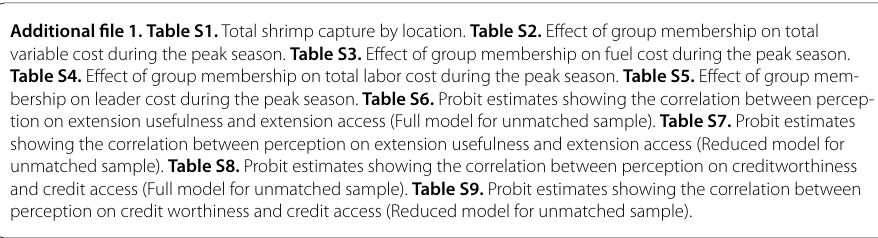
Table S4. Effect of group membership on total labor cost during the peak season. Table S5. Effect of group mem- bership on leader cost during the peak season. Table S6. Probit estimates showing the correlation between percep-